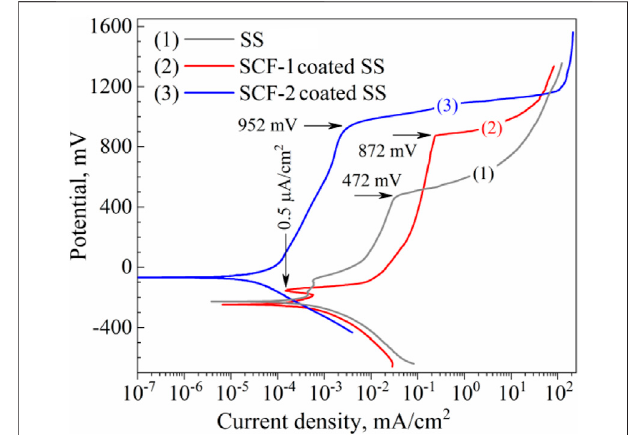
FIGURE 9 | Potentiodynamic plots of the composite coatings and the substrateinSBFsolution.Curves:(1)uncoatedSS,(2)SCF-1-coatedSS,and (3) SCF-2-coated SS,